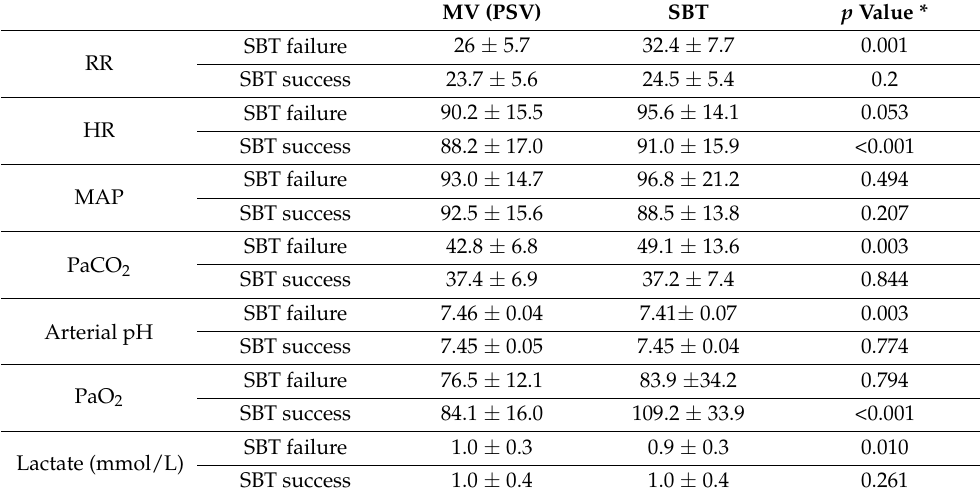
Table 2. Changes in vital signs, lactate, and arterial blood gasses during SBT ( n =